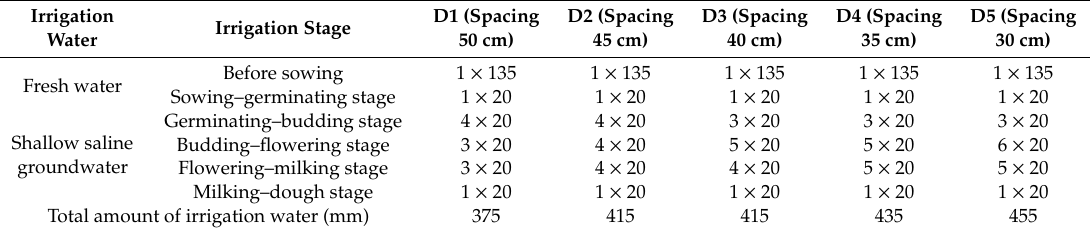
Table 4. The irrigation schedule for di ff erent planting densities in 2016.